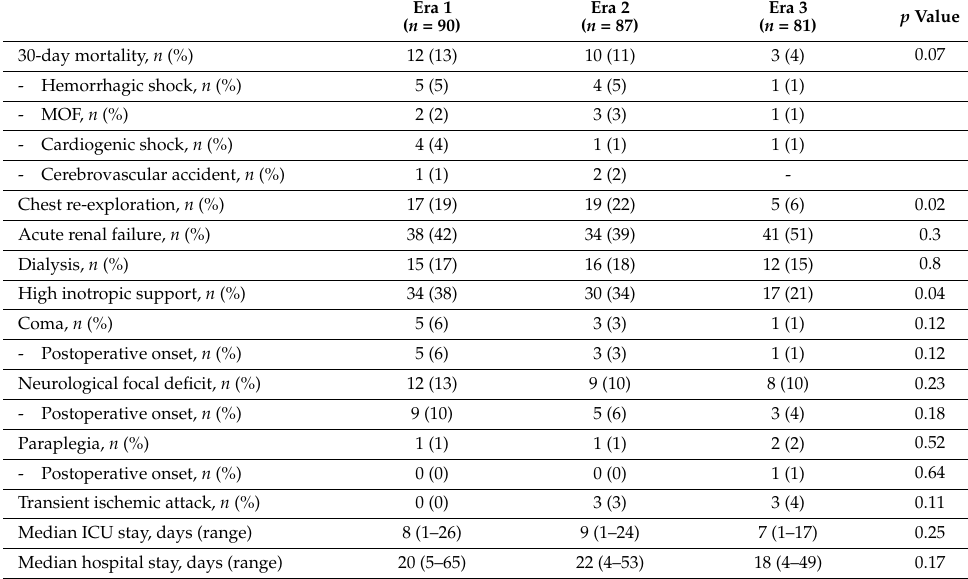
Table 3. Perioperative results.